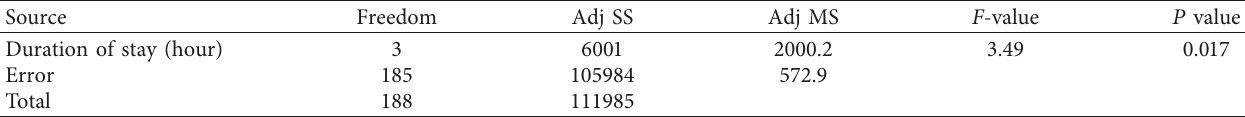
Table 1: Variance analysis table for duration and travel time.